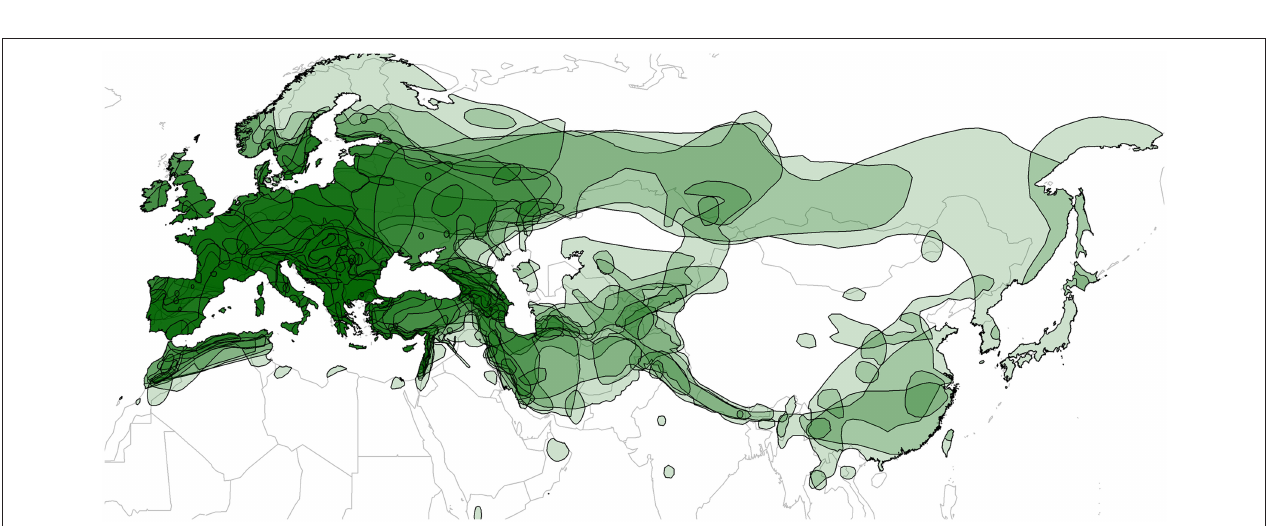
FIGURE 3 | Map of geographic ranges for the 21 European bat species studied. Transparent layers were mapped on top of one another to highlight regions with dense range overlap, primarily in Europe and the Middle East. Some species have additional overlap in Central and East Asia. Individual maps are shown in Figure S2 .